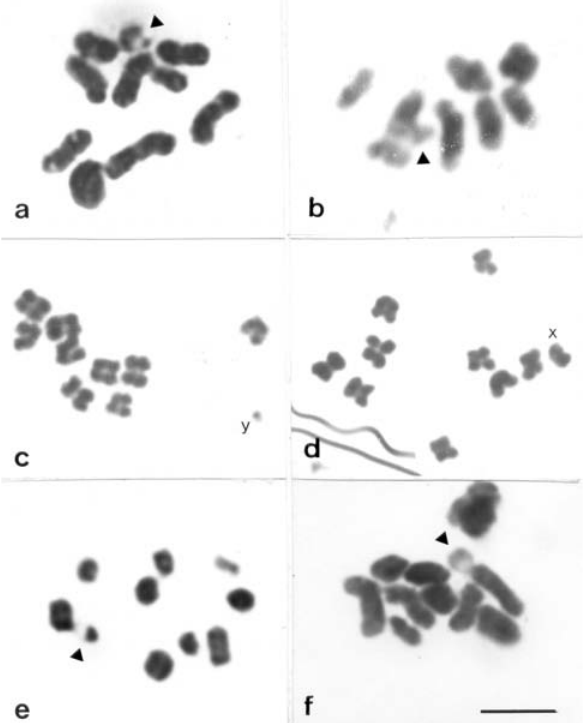
Figure 1 - Meiotic chromosomes stained with acetic orcein. Metaphases I of G. borelli (a) M. festiva (b), L. ebenus (e) and S. s hirtus (f). Note the parachute configuration of the sex pair (arrowheads). Metaphases II of P. pallidipennis (c, d), note the sex chromosomes. Bar = 5 (cid:1)